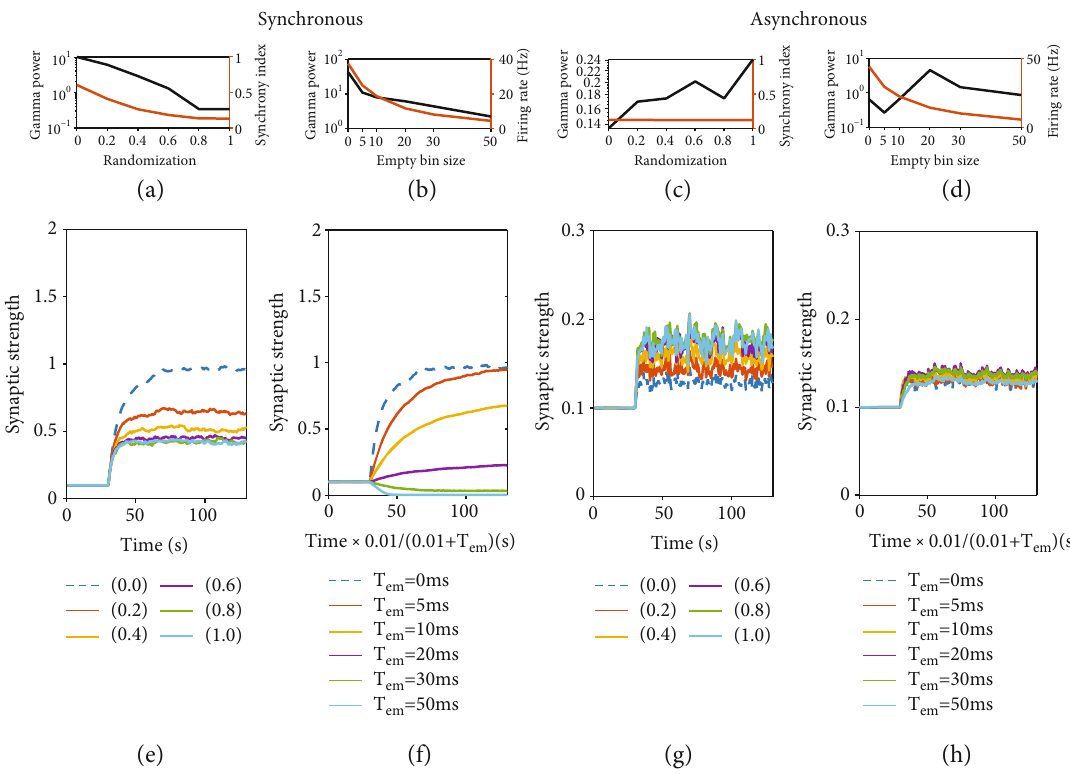
Figure 3: E ff ect of fi ring rate and synchrony on virtual synaptic weight evolution under plasticity. (a, e, c, g) The e ff ect of spike time randomization. (b, f, d, h) The e ff ect of empty bin inserting. (a – d) The gamma power and fi ring rate of the network depend on the proportion of randomization/size of empty bin insert. (e – h) The change of synaptic weight with time. The time axis in (f, h) is modi fi ed based on the empty bins insert. (a, b, e, f) Synchronous state. τ E = 6ms . (c, d, g, h) Asynchronous state. τ E = 90ms . The other parameters d d = 8ms, As = 3 : 5 are set as τ I d